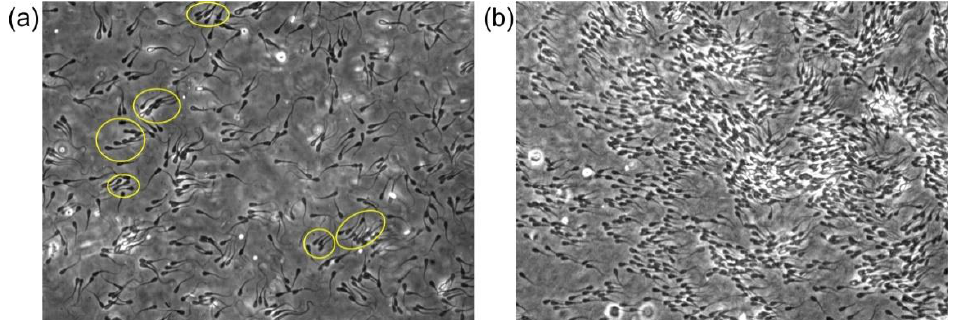
Figure 6. Bull sperm collective swimming in viscoelastic fluid. ( a ) At lower sperm numbers and 1% PAM solution, sperm form nonbinding clusters (yellow ovals) in which several neighboring sperm swim in the same direction. ( b ) At higher sperm numbers and 0.7% PAM plus 1% PVP solution (PVP was added to increase the fluid viscosity to reduce thermal-like randomization), after a pulse of flow was applied and had dissipated, a mass of sperm swam toward the same direction.